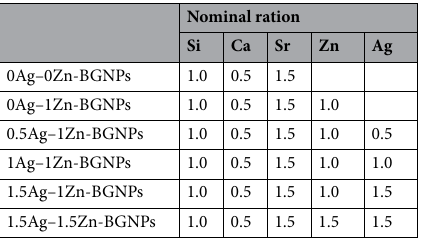
Table 3. Compositions of bioactive glass nanoparticle (nominal ratio).